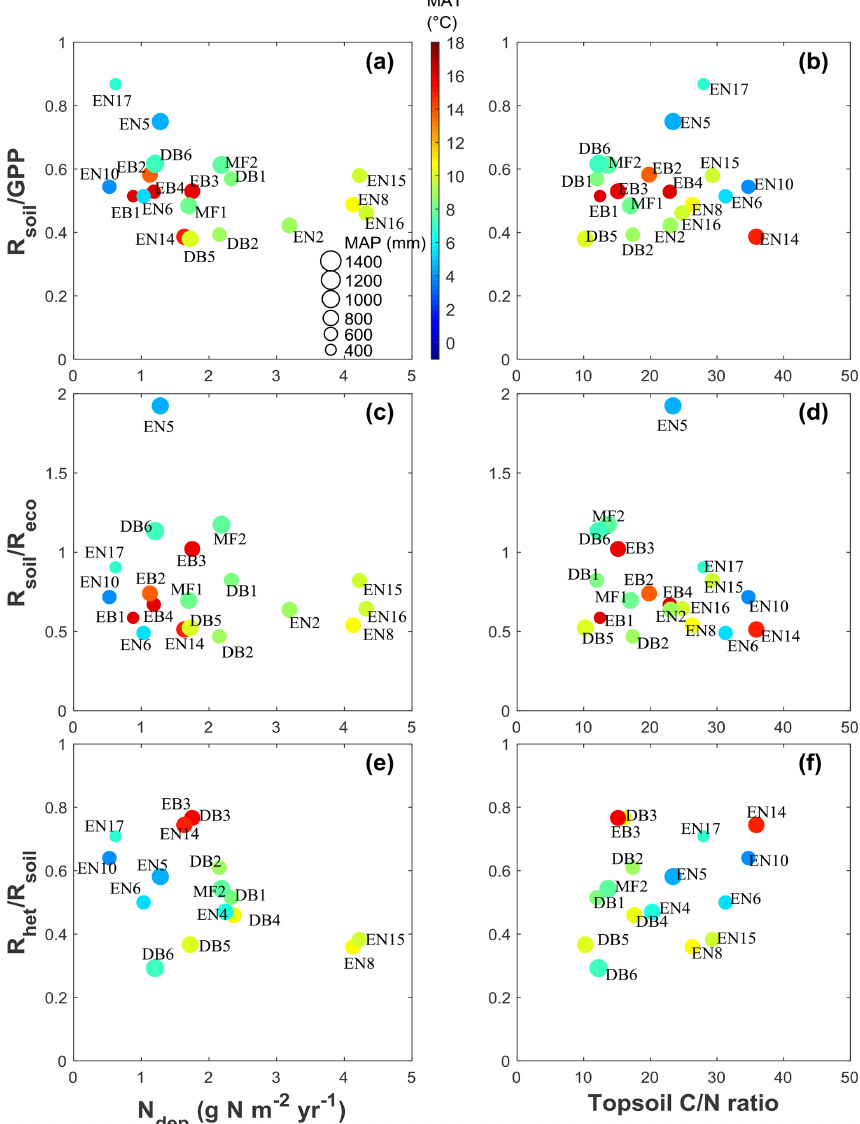
Figure 11. Variability of normalized soil respiration metrics as a function of nitrogen deposition (a, c, e) and soil organic carbon (b, d, f) . In all plots, the colour scale indicates mean annual temperature (MAT), and the symbol size is proportional to mean annual precipitation (MAP). R soil : total soil respiration; R eco : total ecosystem respiration; R het : heterotrophic component of R soil ; GPP: gross primary productivity. DB: deciduous broadleaf; EN: coniferous evergreen needleleaf; EB: Mediterranean evergreen broadleaf; MF: mixed needleleaf–broadleaf